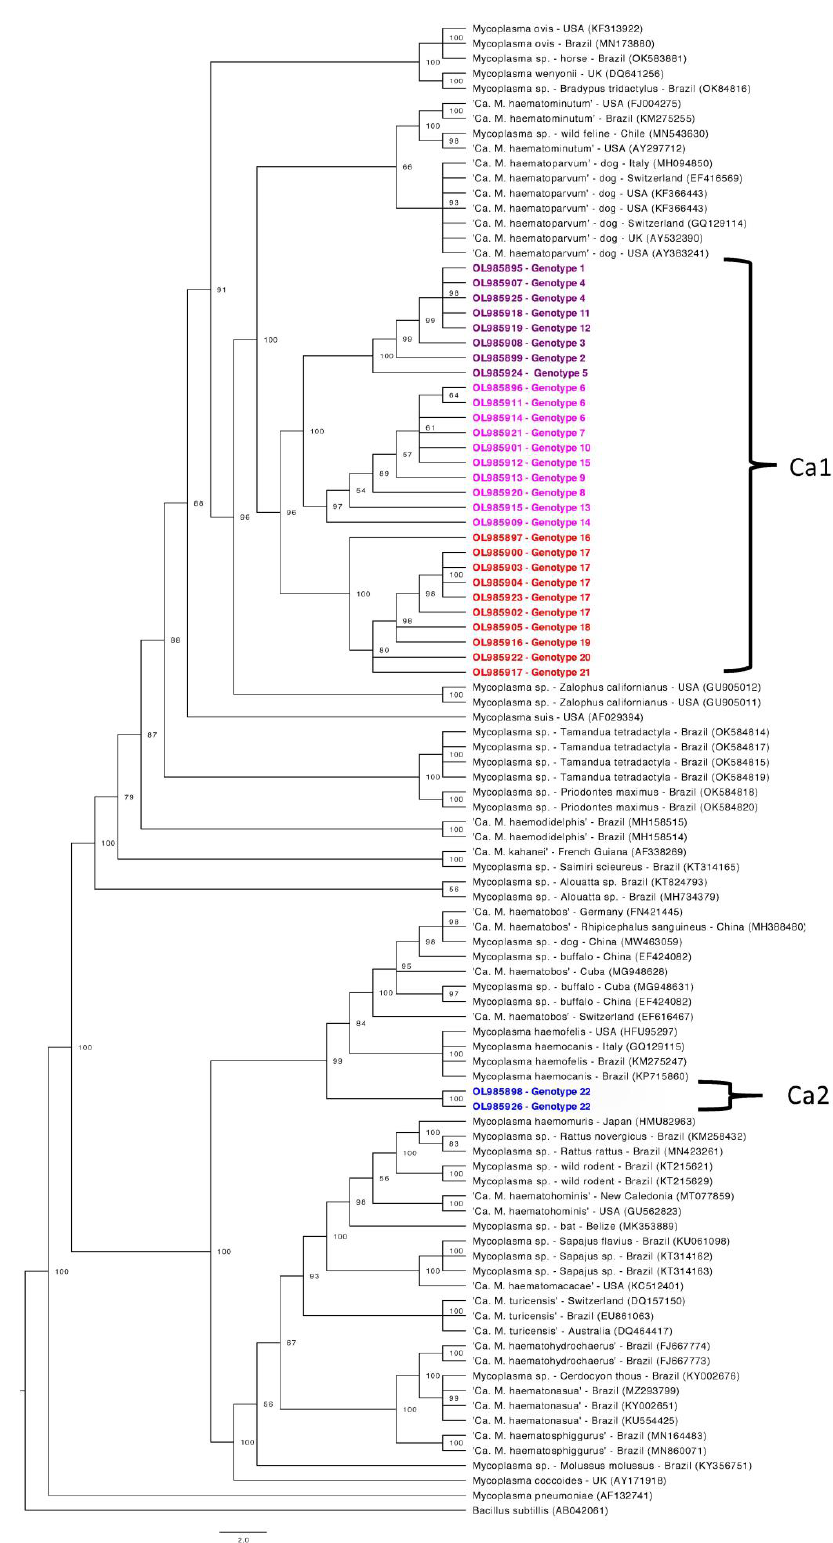
Figure 1. Phylogenetic tree based on partial 16S rRNA gene fragments of Mycoplasma sp. Tree was constructed by Bayesian Inference and a sequence from Bacillus subtillis (AB042061) was used as outgroup. Sequences obtained in the present study (Ca1 and Ca2) are highlighted in colors: Ca1 are highlighted in purple, pink and red colors, differentiating each subclade formed. Ca2 is highlighted in